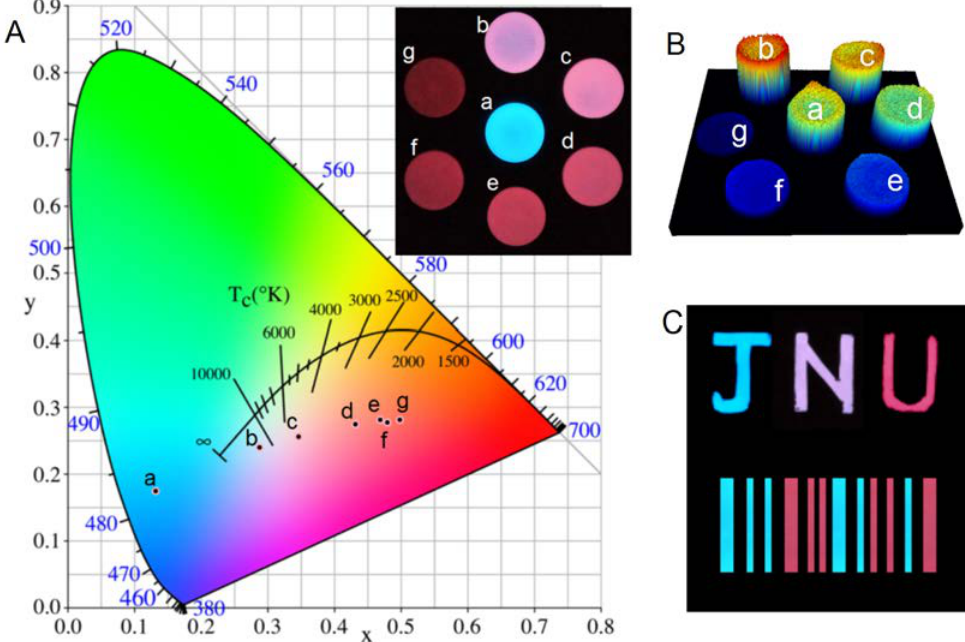
Figure 7. ( A ) CIE (Commission Internationale de L'Eclairage) chromaticity diagram and